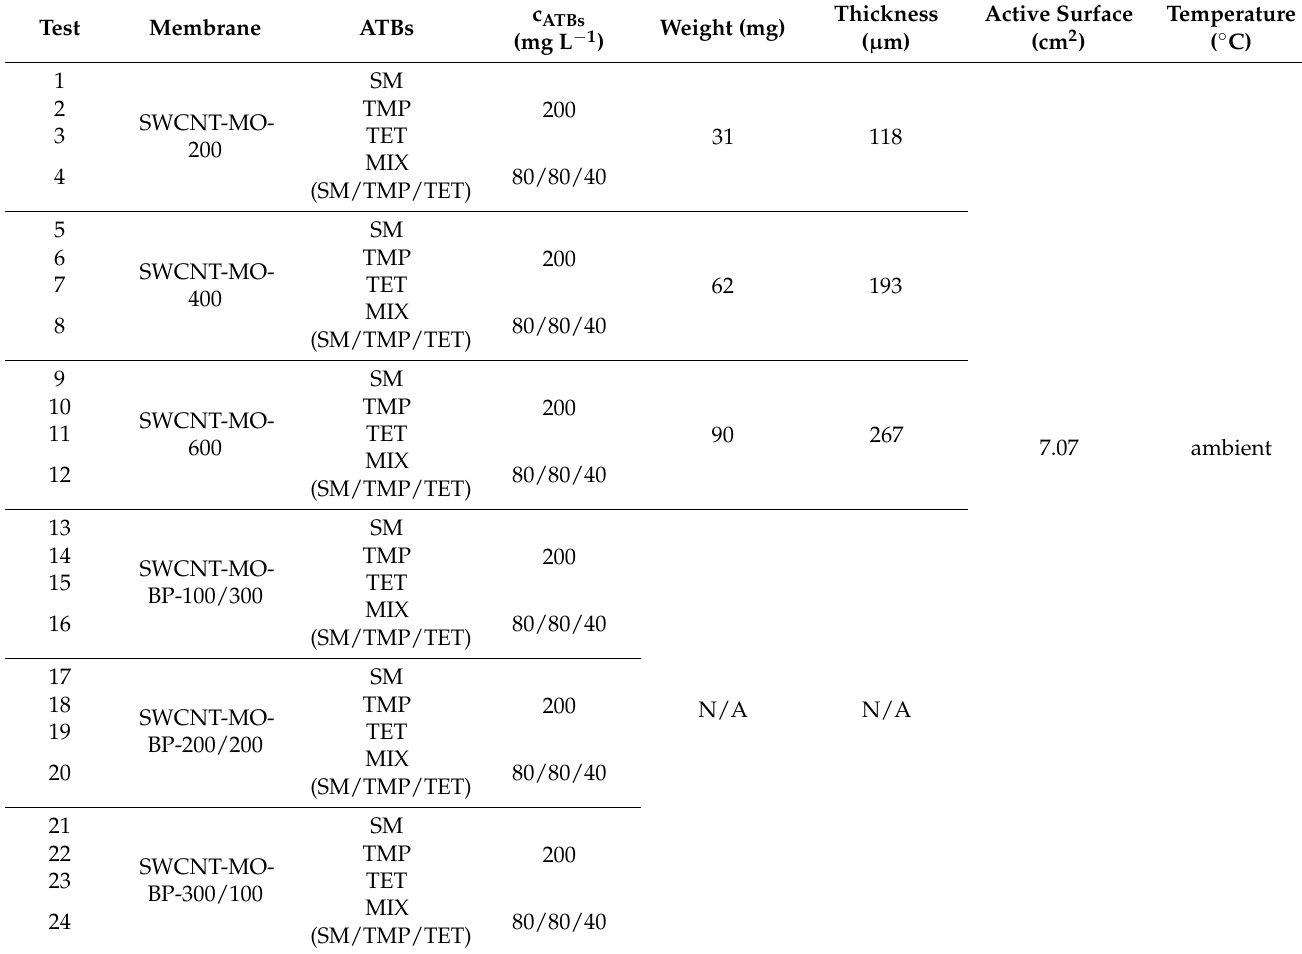
Table 8. Sorption tests of ATBs using SWCNT